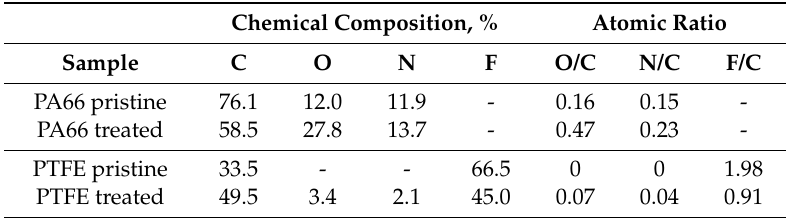
Table 3. Surface composition (atomic %) of the pristine and plasma treated polymer samples determined by XPS (the error of the quantitative results is ± 5 rel.%).